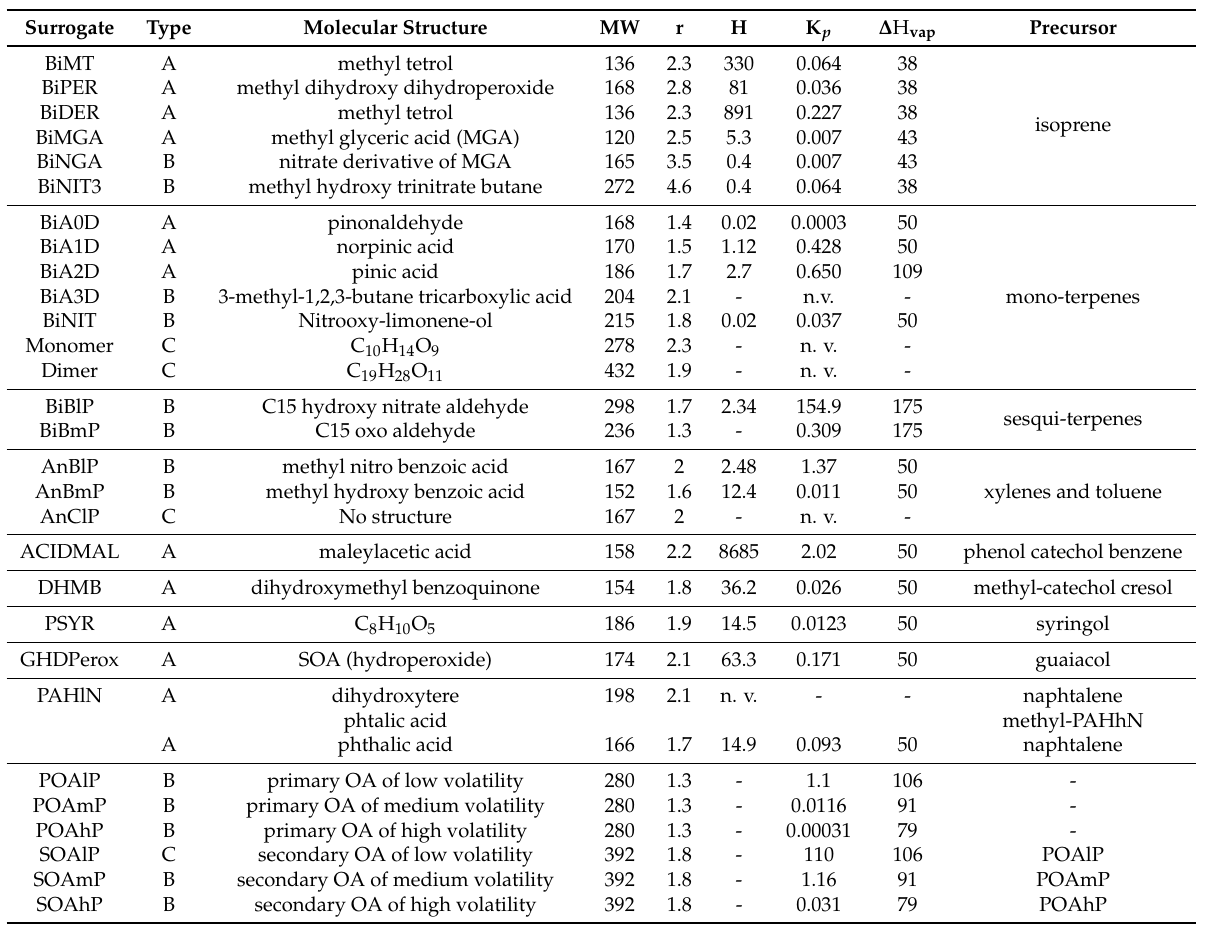
Table A2. Characteristic of the surrogates for aerosol organic species: abbreviation of the surrogate type: Type A, hydrophilic; Type B, hydrophobic; Type C, hydrophobic non-volatile and not used to compute activity coefficients. Molecular structure, molecular weight MW (g · mol − 1 ), OM/OC ratio r, Henry’s law constant H ( × 10 8 M/atm), partitioning constant K p (m 3 µ g − 1 ) for an ideal organic phase of molar mass 200 g/mol at 298 K, enthalpy of vaporization (kJ · mol − 1 ), and precursors. The abbreviation n.v. means non